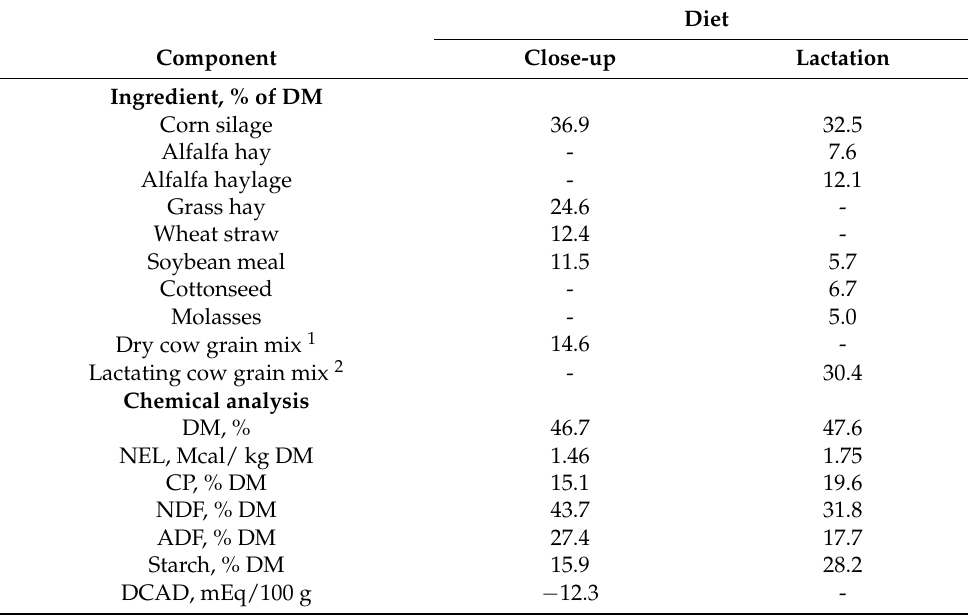
Table 2. Ingredient composition of diets during the close-up ( − 21 d to expected calving) and early lactation periods (21 d relative to